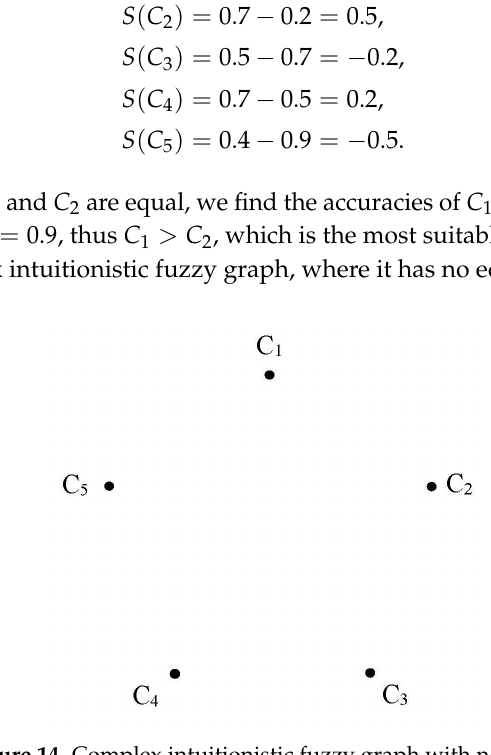
Figure 14. Complex intuitionistic fuzzy graph with no